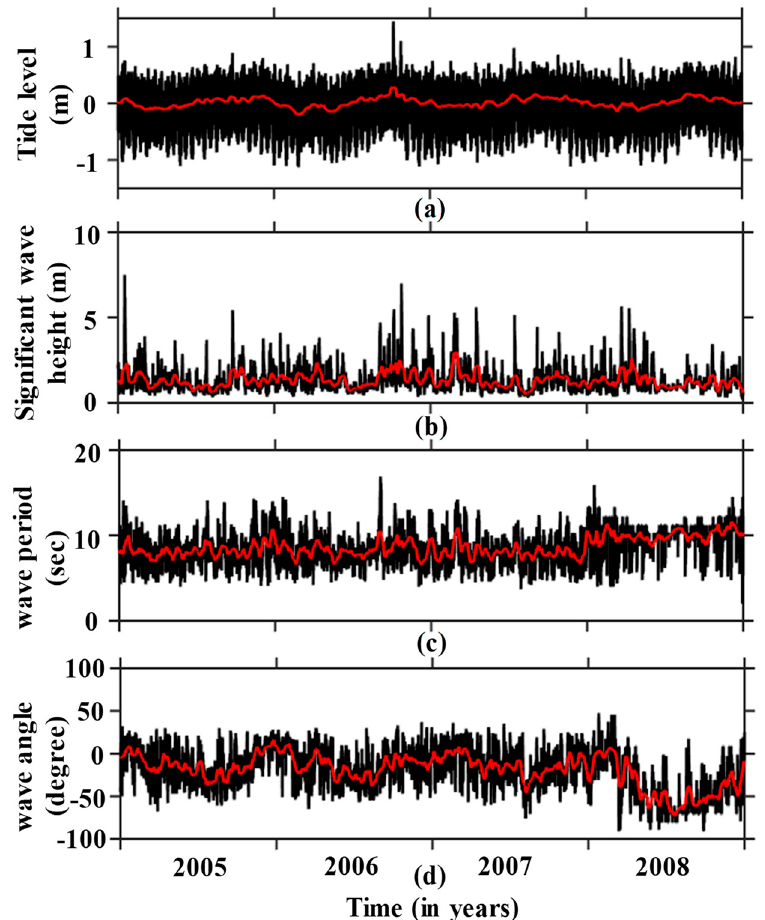
Figure 2. The temporal variations of ( a ) the tide level, ( b ) the significant wave height, ( c ) the wave period, and ( d ) the wave direction during 2005–2008. The red line indicates the 14-day moving average of the respective data.